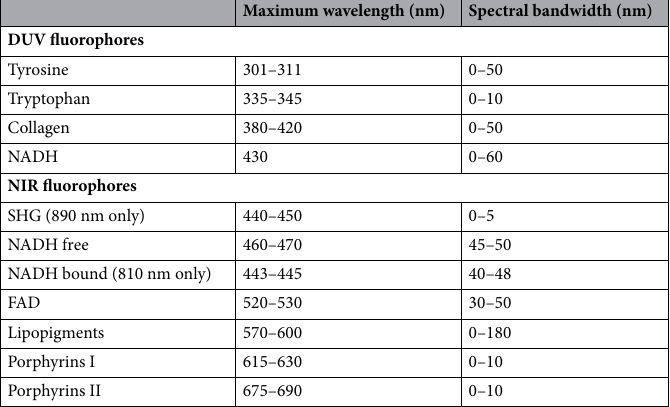
Table 1. Gaussian Parameters taken into account to fit the fluorescence emission spectrum of the endogenous fluorophores excited in DUV range (275 nm) and in NIR range (810 nm and 890 nm).